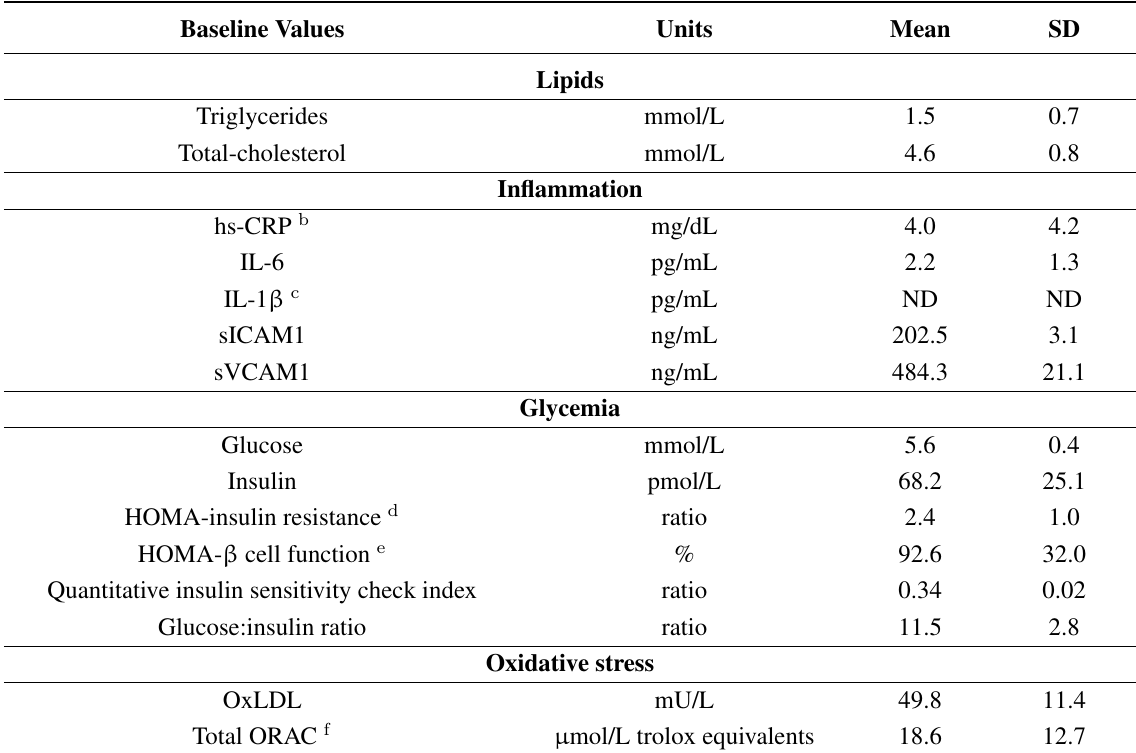
Table 2. Baseline Labs ( n = 12) a .